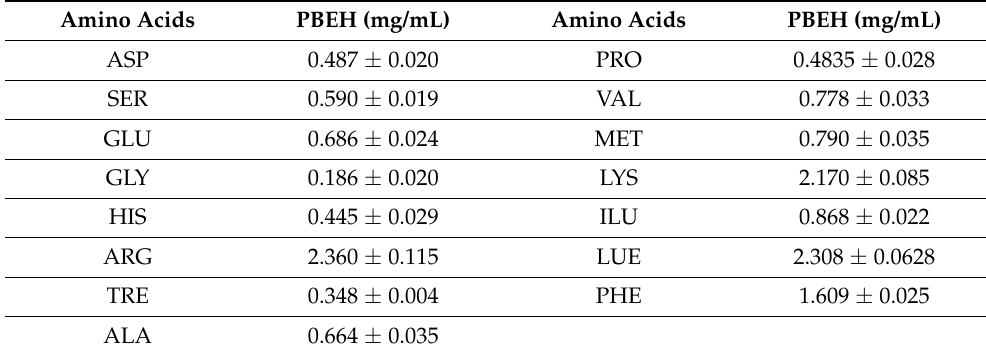
Table 1. Amino acid composition in porcine brain enzyme hydrolysates (PBEH). Amino